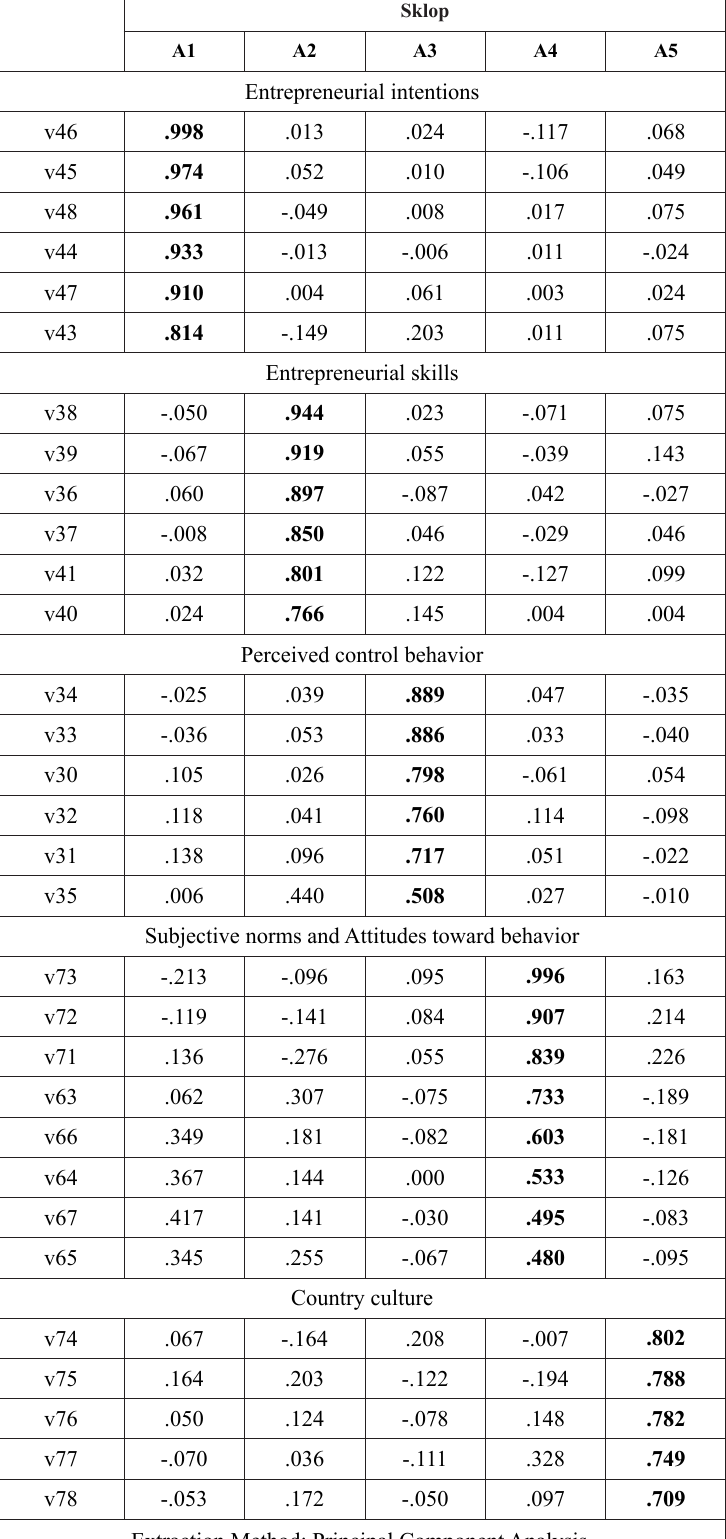
Table 5. Composition of factors (A) of students’ entrepreneurial